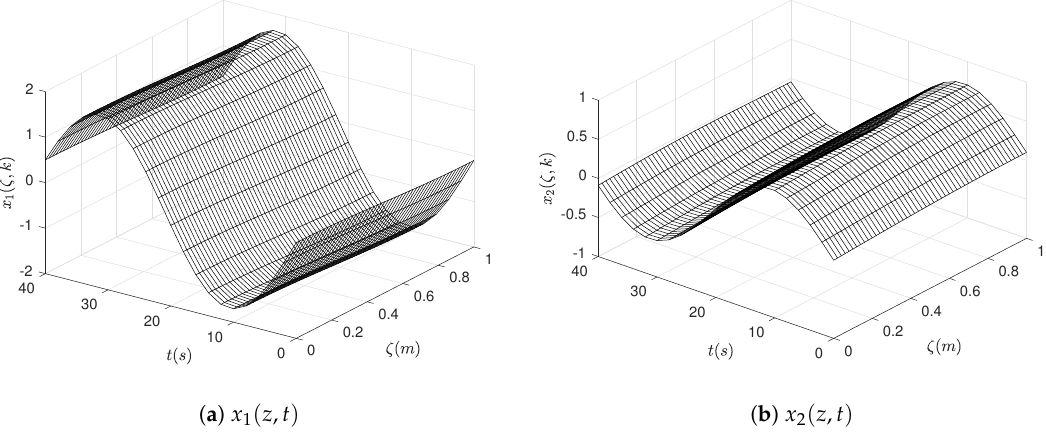
Figure 9. State evolution of the noise-free wave system.